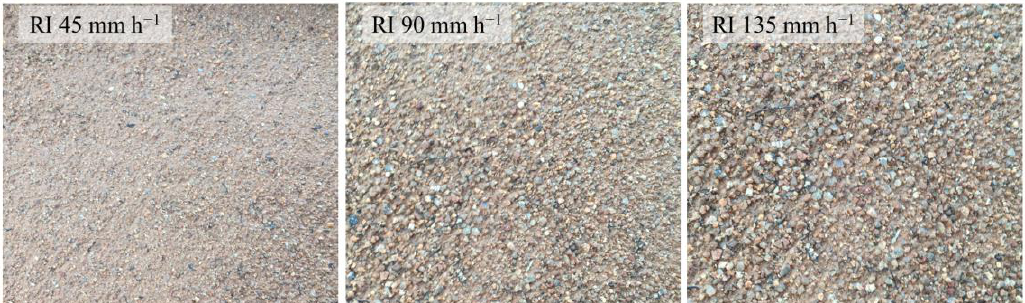
Figure 9. The coarsen feature of the soil surface under different rainfall intensities.